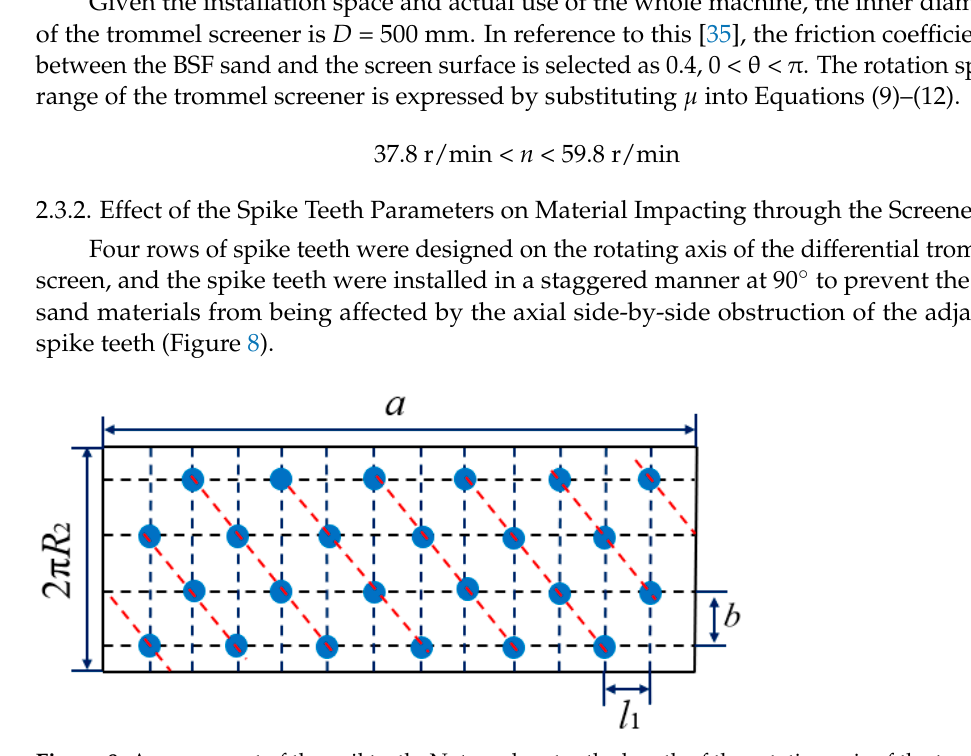
Figure 8. Arrangement of the nail teeth. Note: a denotes the length of the rotating axis of the trommel screener, m; l 1 represents the teeth trace distance, m; R 2 is the radius of the rotation axis, m; and b expresses the spike teeth spacing, m.